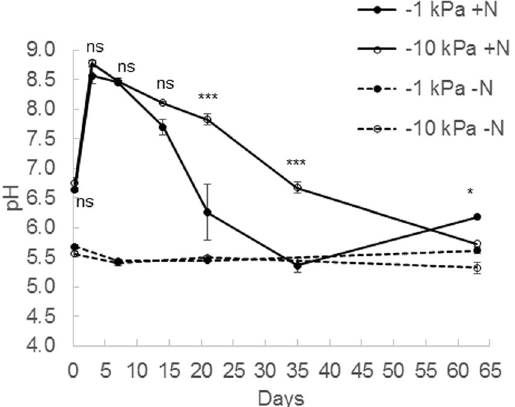
Figure 2. Changes in soil pH over time. Soil pH under near saturated ( − 1 kPa) or field capacity ( − 10 kPa) soil moisture conditions, following urea application ( + N) or nil urea application ( − N). Symbols are means (n = 4) with vertical error bars the standard error of the mean. Asterisks * , ** , *** indicate significant differences between moisture treatments under urea treatments at P < 0.05, P < 0.01, and P < 0.001,